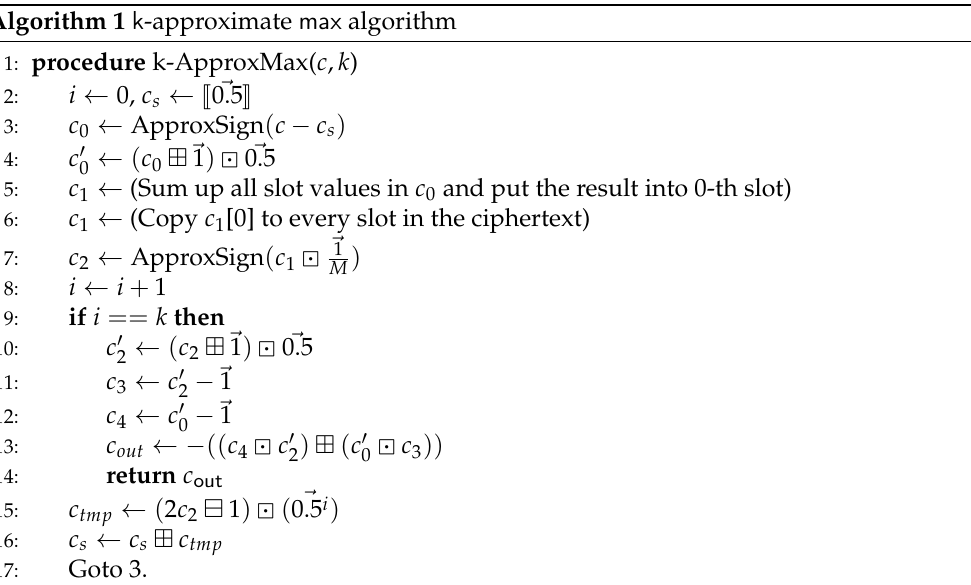
Algorithm 1 k -approximate max